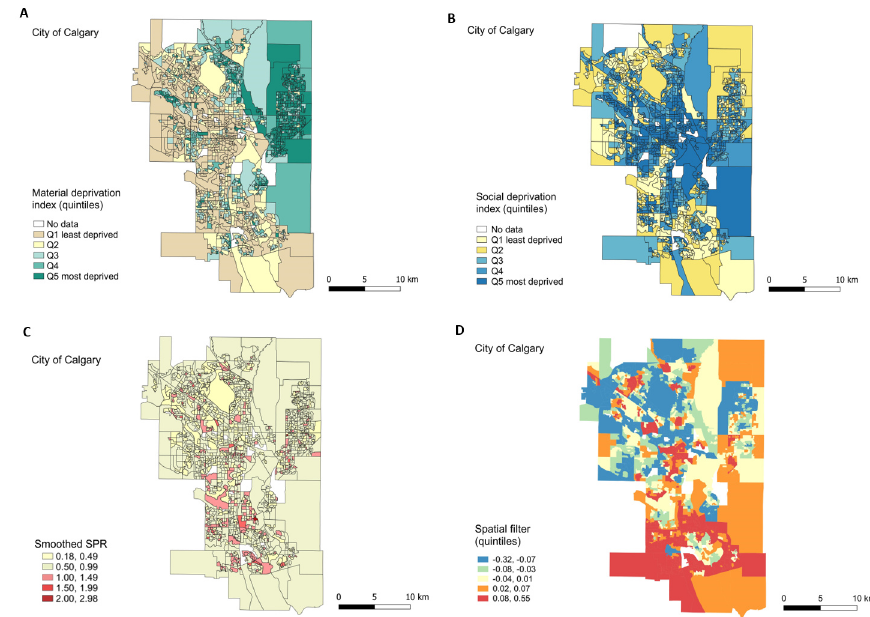
Figure 2. Calgary maps. Geographic distribution of material ( A ) and social deprivation ( B ) quintiles, smoothed SPR ( C ), and spatial filter ( D ). Quintiles were split according to rank values for ( C , D